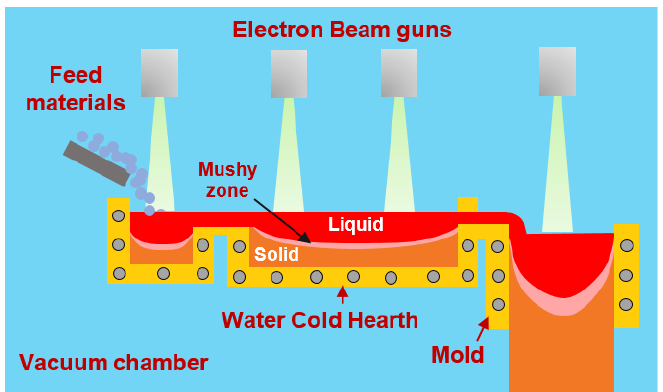
Figure 1. Schematic of the EBCHM process.